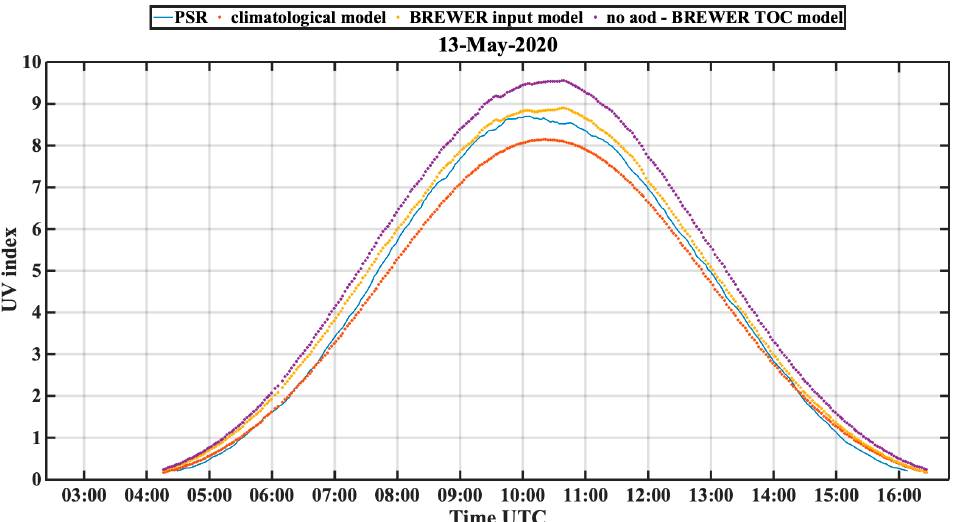
Figure 5. Diurnal variation of UVI on 13th of May 2020 as retrieved from the PSR measurements (blue curve), in comparison with modeled UVI predicted using RTM with climatological TOC and AOD inputs (orange dots) and modeled UVI using BRS AOD and TOC as input and modeled UVI using BRS TOC but zero aerosols.